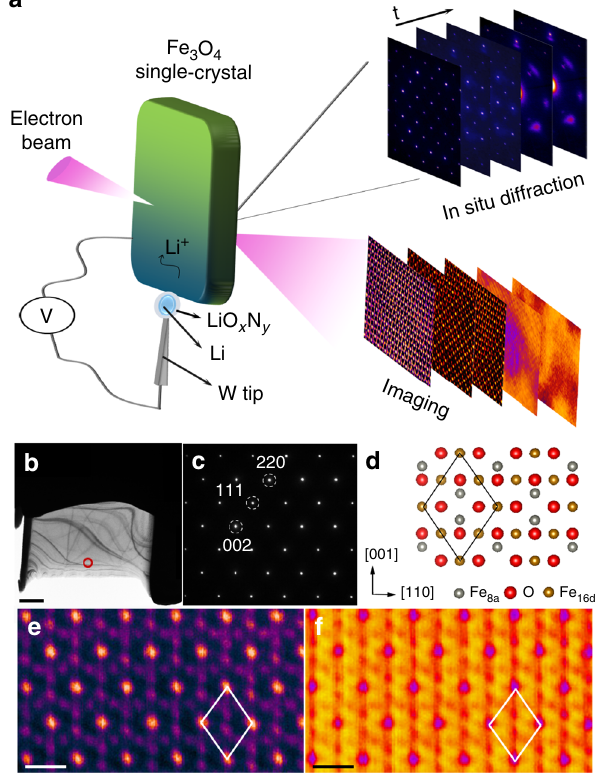
Fig. 1 Experimental setup for tracking electrochemical reaction in a single crystal of Fe 3 O 4 . a Schematic illustration of the experimental design in this study that allows probing of structural evolution at the reaction front, via a combination of time-resolved in situ electron diffraction and spatially- resolved atomic imaging (i.e., providing “ snapshots ” at certain lithiation states). An in situ electrochemical cell specialized for crystallographic studies is designed, with a Fe 3 O 4 single-crystal as an active electrode, Li metal as a counter electrode and natively formed LiO x N y as a solid electrolyte. The individual components of the cell are connected using a piezo-driven biasing probe built into the TEM – scanning tunneling microscopy sample stage. b , c Bright- fi eld TEM image of the Fe 3 O 4 sample, with a large thinned area (brighter) for this study, and the corresponding electron diffraction pattern from the selected area (as labeled by a red circle in ( b )), indicating its orientation along the [1 (cid:1) 10] direction. Scale bar: 1 µ m. d Structure model of the atomic arrangement viewed along the [1 (cid:1) 10] direction, showing the occupancy of Fe at 8a/16d sites and O at 32e sites in the inverse spinel structure (space group: Fd (cid:1) 3m). e , f HAADF and ABF images taken simultaneously from the edge of the slice in ( b ), as labeled by the red circle. Fe atoms can be visualized in the HAADF image, while the O and Fe become distinguishable in the ABF image. Scale bars: 0.5